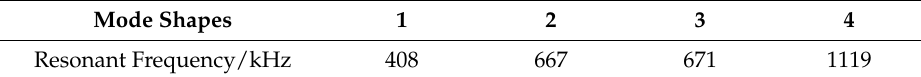
Figure 2. Mode simulation of HGMA structure: ( a ) ( b ) ( c ) and ( d ) are 1st, 2nd, 3rd and 4th order modes.